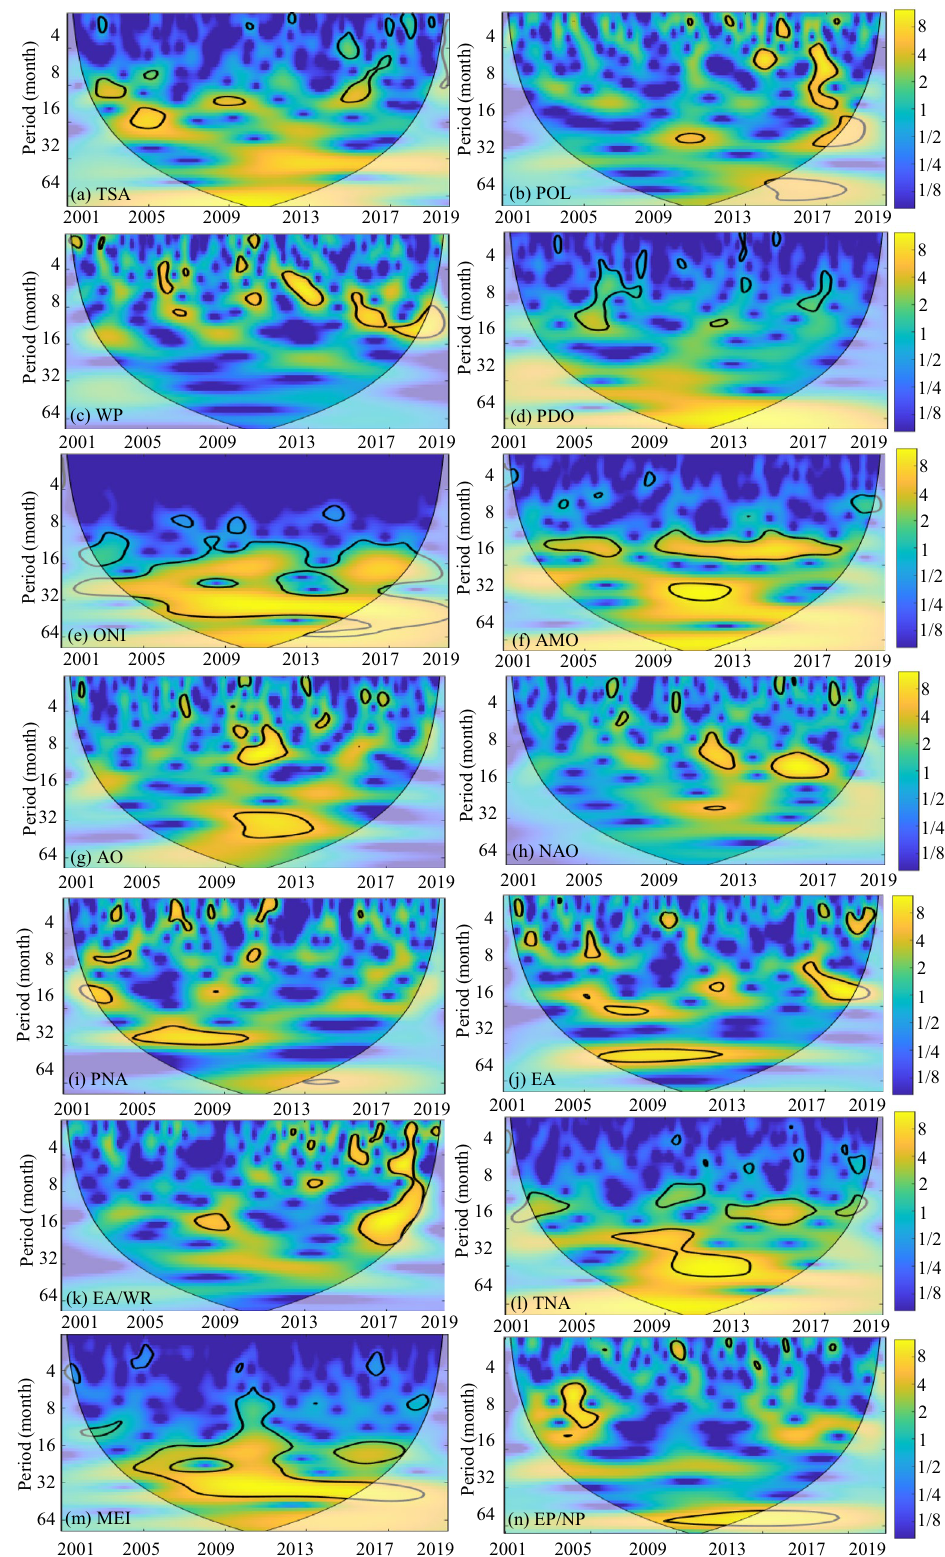
Figure 5. WPS of the large-scale climatic single time series (periodicity of time series). The black contour designates the 95% confidence level against red noise, and the COI, where edge effects might distort the picture, is shown as a lighter, paler shade. (DMI and AAO, which have no significant impact on any DEOFs, are removed). This figure was generated using MATLAB version R2020b (https:// jp. mathw orks. com/). The data used in the calculation comes from Fire CCI v5.1 dataset (https:// geogra. uah. es/ fire_ cci/ firec ci51. php) and NOAA (https:// psl. noaa. gov/ data/ clima teind ices/